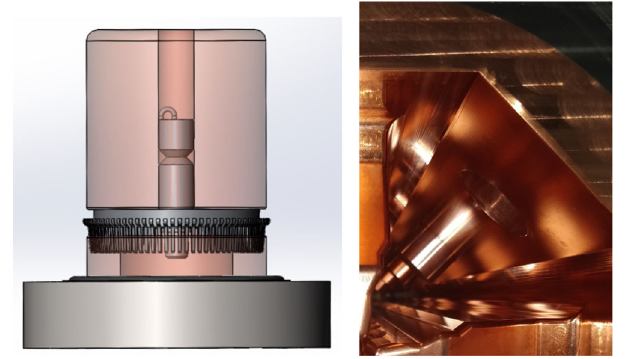
FIG. 5. Half-width of the vane base and inter-vane voltage versus the longitudinal position.